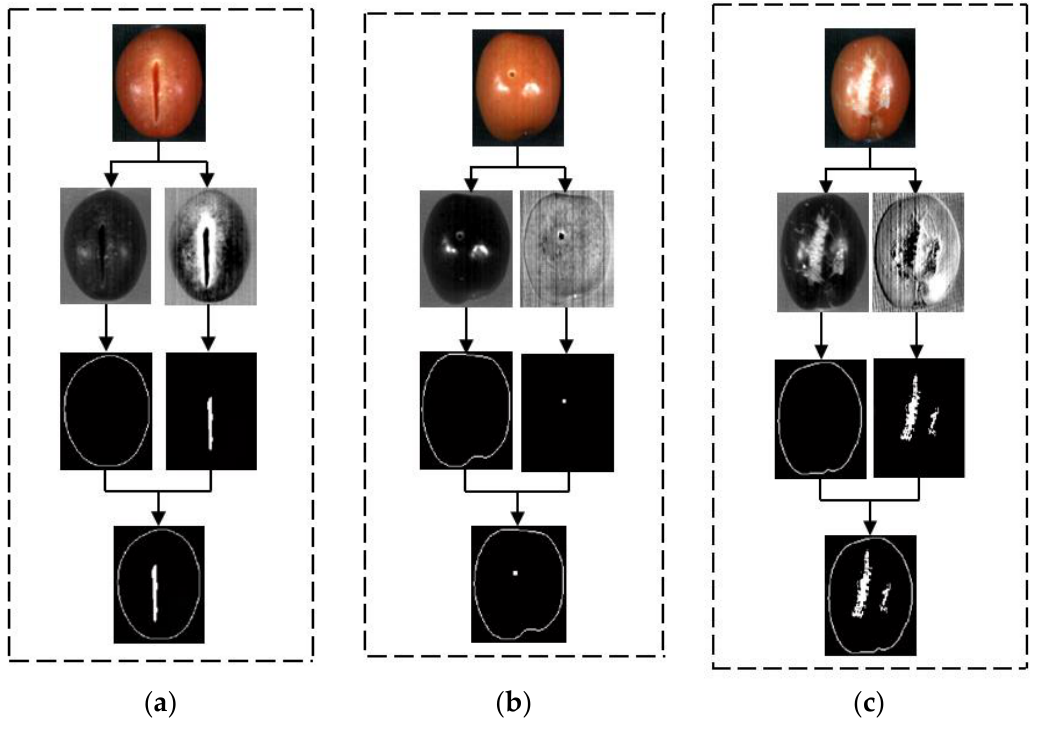
Figure 10. The identification of Cerasus humilis fruit with defective features: ( a ) cracked sample; ( b ) insect damage sample; ( c ) rust spot sample. Table 5. Test results by applying the developed algorithm to 105 independent samples with differ- ent defect types.